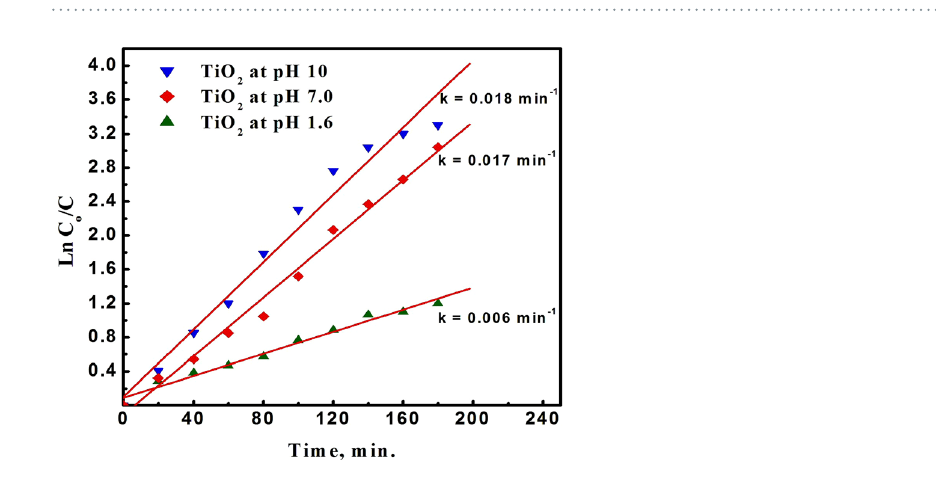
Figure 9. Pseudo first order rate kinetics for photocatalytic degradation of methylene blue dye using TiO 2 NPs prepared at different pH values; 1.6, 7.0 and